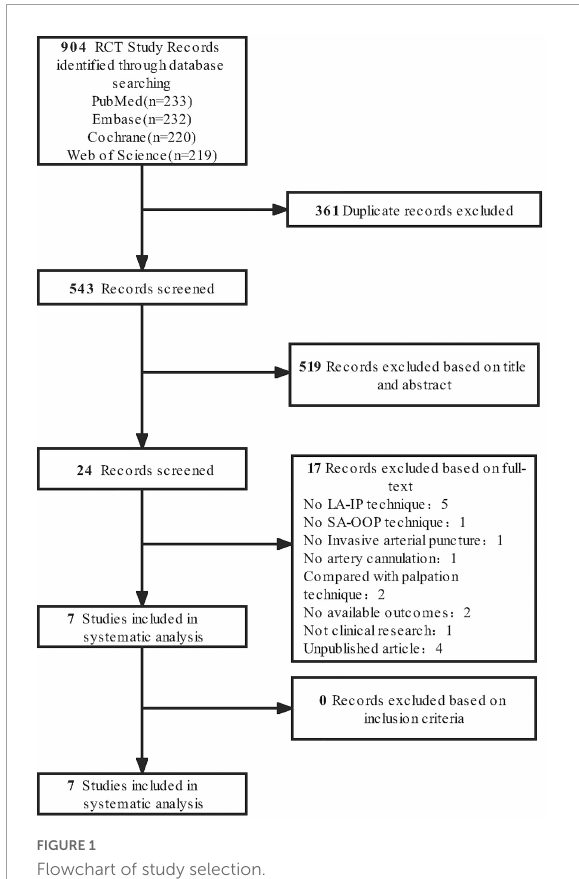
FIGURE1 Flowchart of study